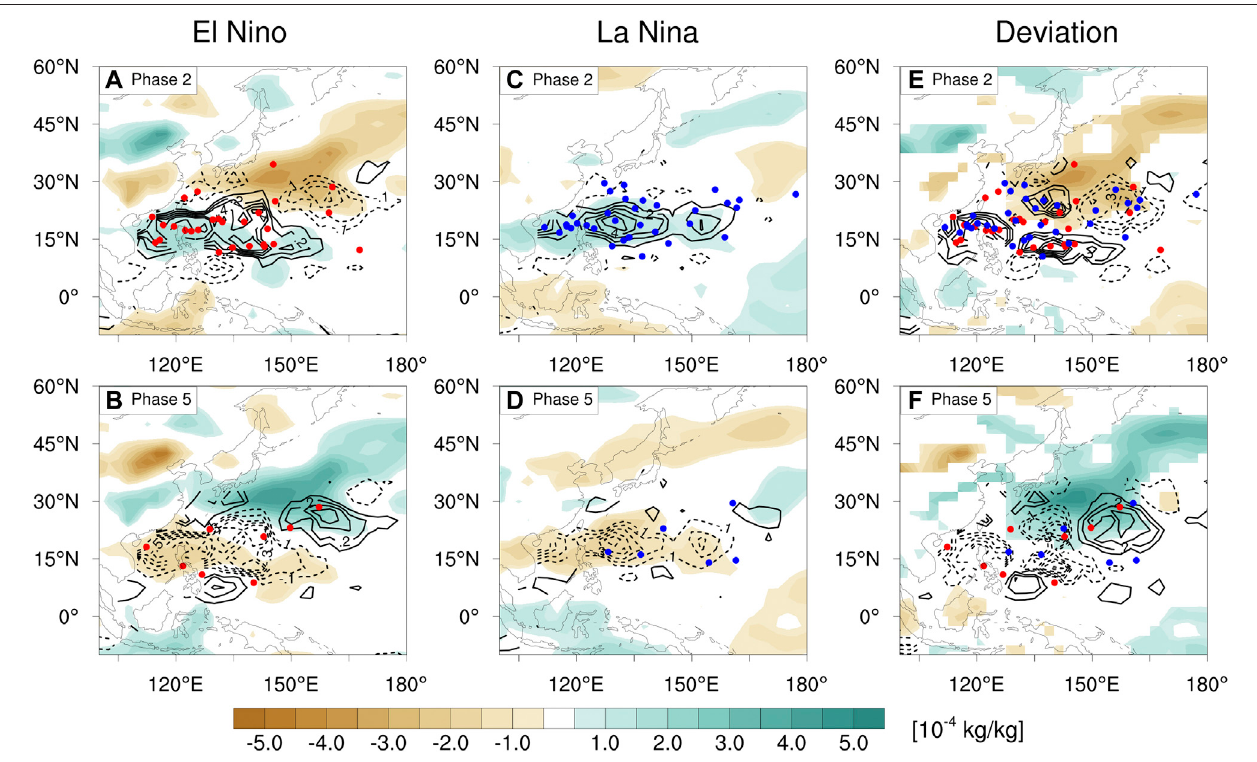
FIGURE 10 | The composition of speci fi c humidity (kg/kg, shaded) at 850 hPa and GPI (contour) with the period of 20 – 30 days for El Niño years (A – B) and 50 – 70 days for La Niña years (C – D) and their difference (El Niño minus La Niña) fi elds (E – F) based on the phase of the EAP index. The deviations are passing the 95% con fi dence level. The black (green) dots represent the positions of MTC genesis in El Niño (La Niña) summers.